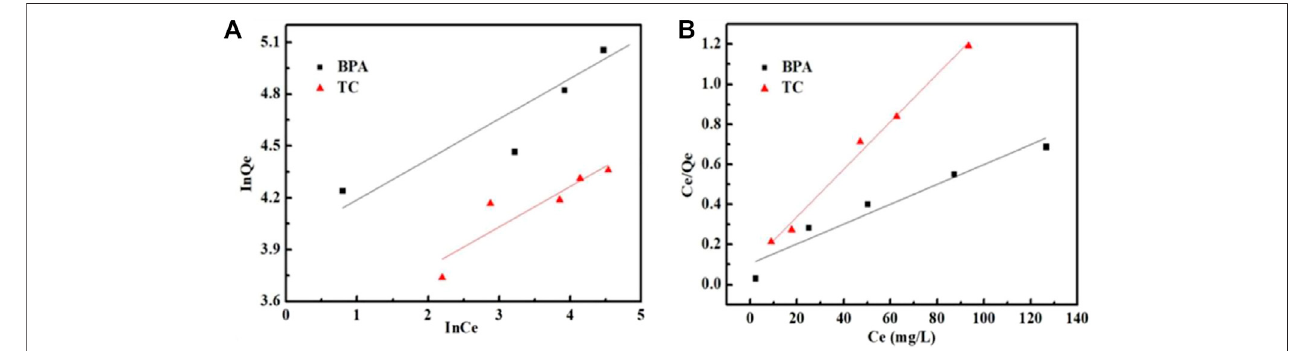
FIGURE 7 | Adsorption isotherm curves of BPA and TC on Fe 3 O 4 @MIL-53(Al)-NH 2 . (A) Freundlich model; (B) Langmuir model.